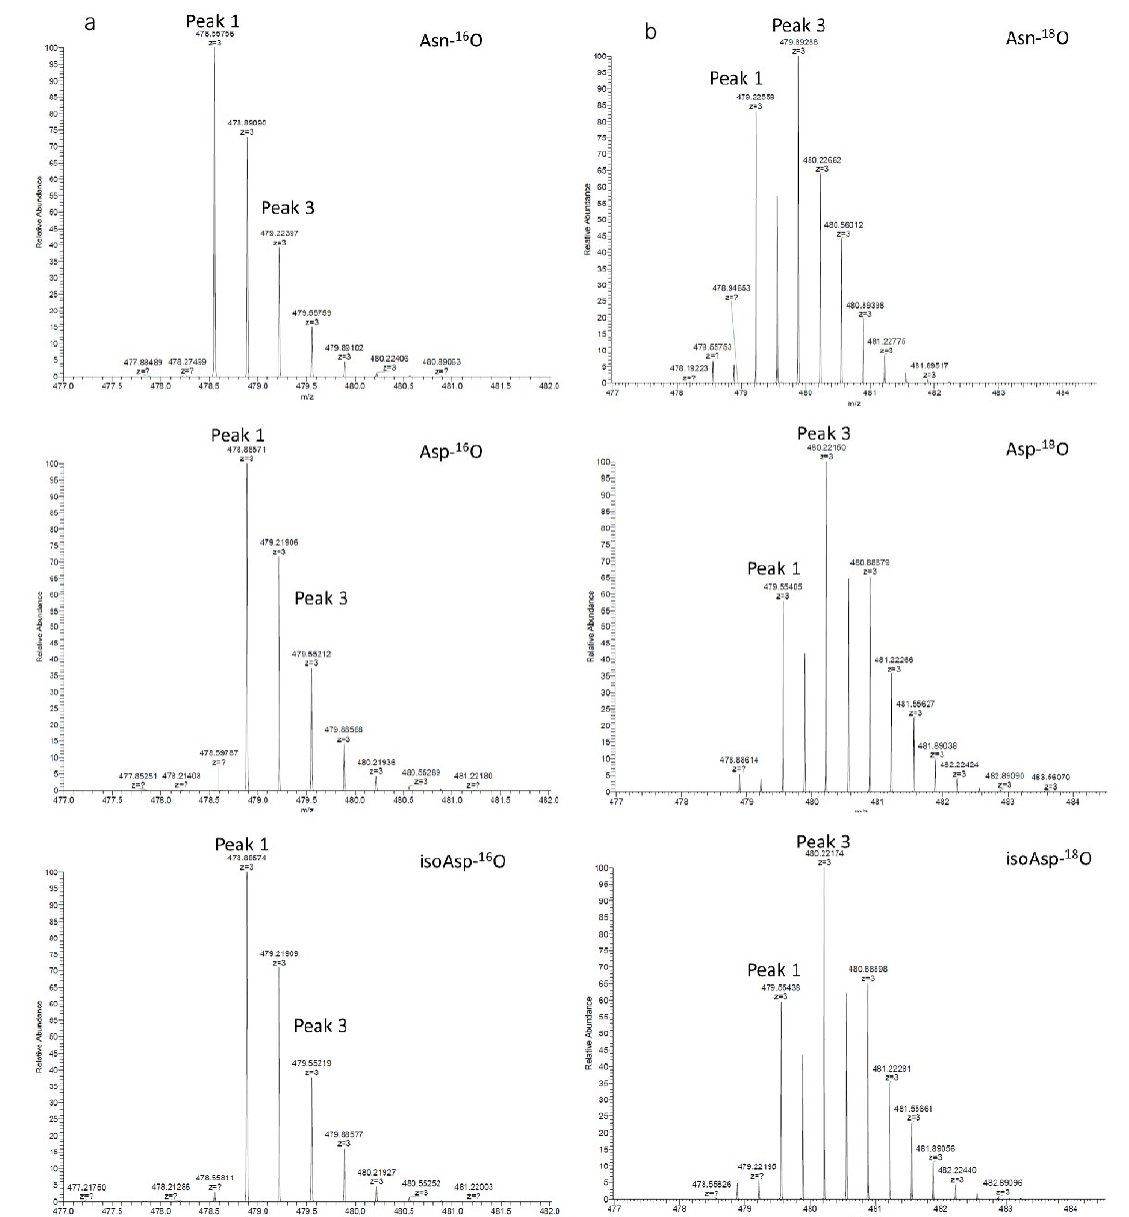
Figure 2. Mass spectra of the triply charged peptide R39-E51 obtained from digestion in normal water ( 16 O, a ) and 18 O-enriched water ( 18 O, b ). The mass spectra are labelled